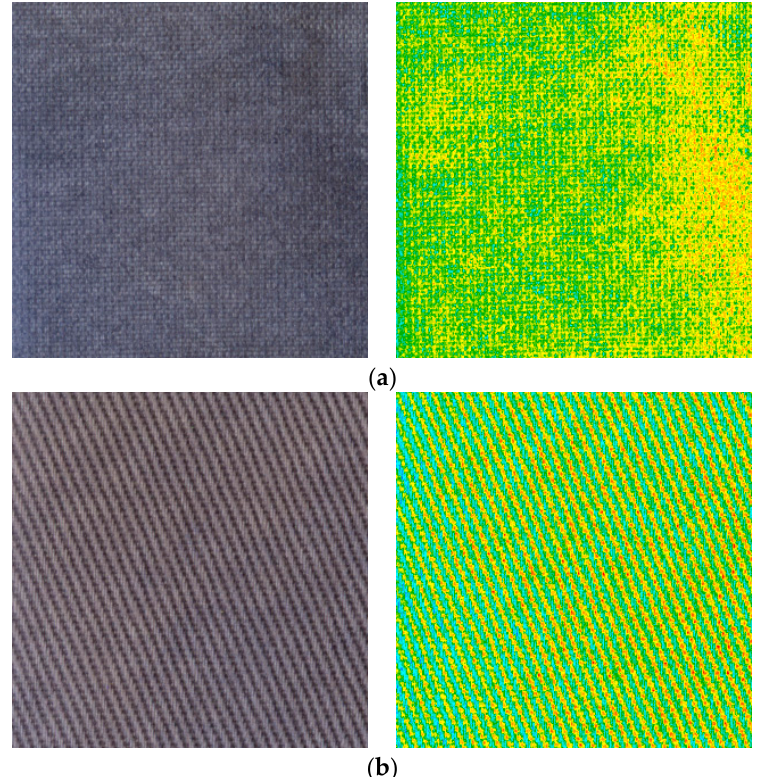
Figure 7. Green channels maps (second column) for polyamide ( a ) and cotton ( b ) fabrics printed with NBT-Pluronic F-127 hydrogel and irradiated with 2 J/cm 2 of UVB radiation (first column). In the next stage, the profiles of green RGB channels across the samples were deter- mined for polyamide and cotton samples before and after irradiation with UVB (Figure 8). The obtained results indicated that the polyamide fabric weave generates less disturb- ance of the printed surface unevenness (Figure 8a) compared to the cotton fabric weave (Figure 8b). The unevenness of the polyamide fabric also increases with the absorbed dose of UVB radiation. However, when analyzing the shape of the profiles, it can be seen that the uniformity of printing on the surface of cotton fabric is better than that for polyamide (Figure 8c). It is also seen that the non-printed cotton fabric is more uniform and creaseless.